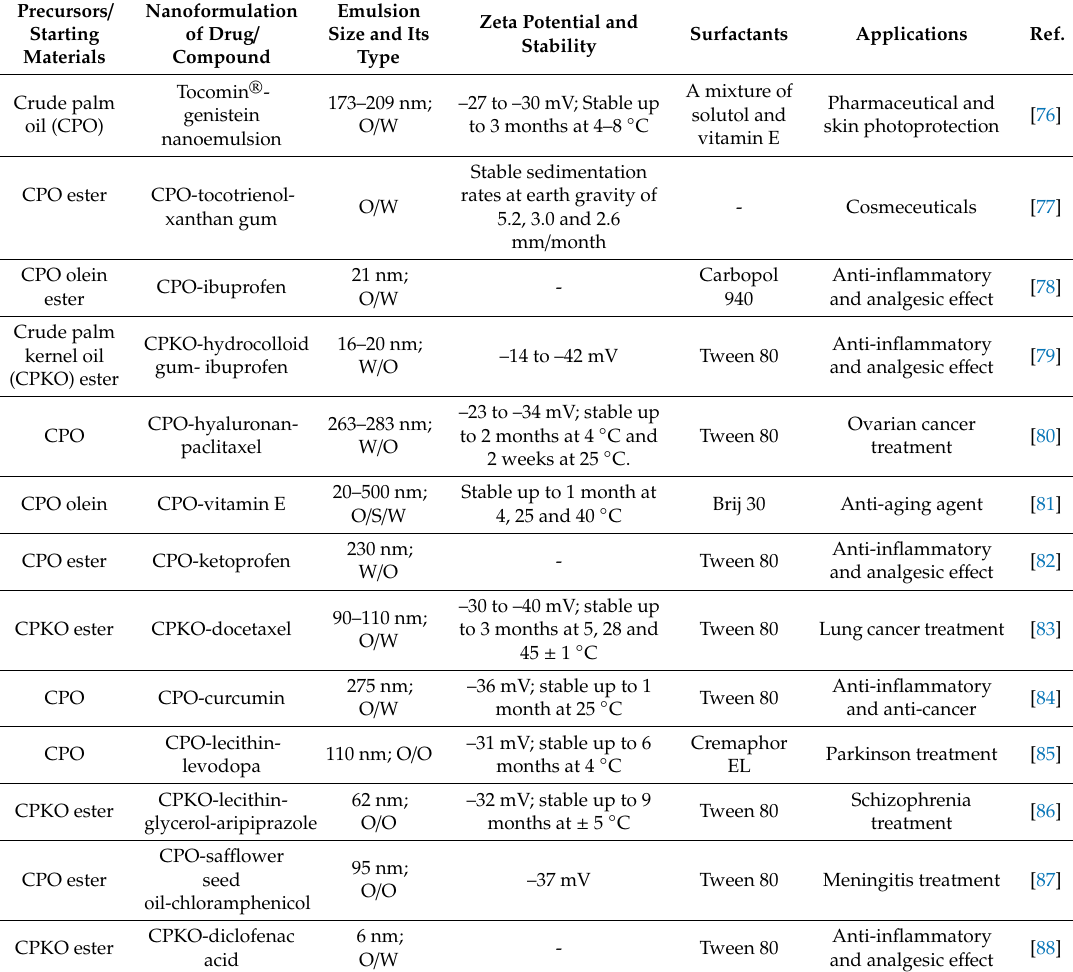
Table 1. Applications of palm oil matrices as a lipid-based carrier